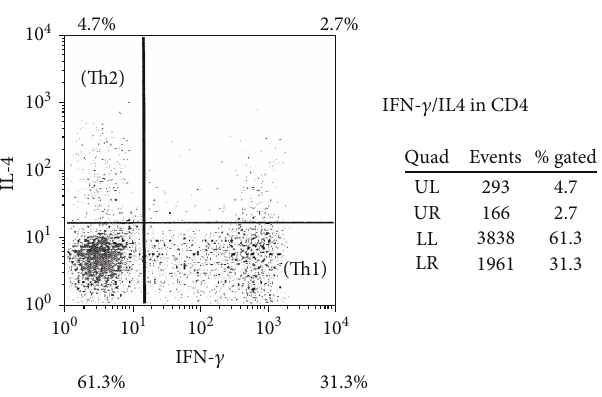
Figure 2: Flow cytometric detection of interferon- (IFN-) γ and interleukin- (IL-) 4 in CD4-positive T cells. Upper left: IFN- γ - negative/IL-4-positive cells (Th2 cells); lower right: IFN- γ - positive/IL-4-negative cells (Th1 cells); upper right: IFN- γ /IL-4 double positive cells (Th0